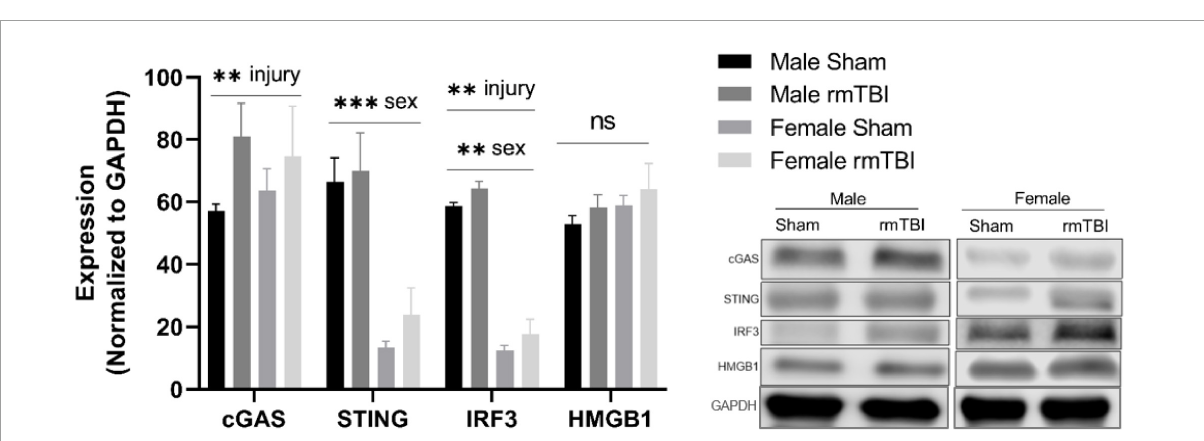
FIGURE5 cGAS-STING mediated signaling 1 week post-rmTBI. Western blotting was used to quantify proteins involved in cGAS-STING signaling 1 week after rmTBI. cGAS was significantly increased in rmTBI mice compared to shams ( p = 0.005, main effect of injury) with no sex differences. STING was significantly affected by sex ( p < 0.0001, main effect of sex), and although trending toward increased expression did not reach statistical significance for effect of injury. Post-hoc analysis revealed STING was significantly increased in sham males compared to both sham and rmTBI females (both p < 0.0001, Tukey HSD), and rmTBI males compared to both sham and rmTBI females (both p < 0.0001, Tukey HSD). IRF3 was significantly increased by injury ( p = 0.002, main effect of injury) and affected by sex ( p < 0.0001, main effect of sex). Similar to STING, post-hoc analysis indicates that IRF3 expression was significantly higher in sham males compared to both sham females and rmTBI females ( p < 0.0001, Tukey HSD). No statistical significant change for HMGB1 was observed. All statistical values are results of two-way ANOVAs with n = 4 per sex-segregated group. Error bars represent standard deviation and indication of statistical analysis is as follows: # p < 0.1, ∗ p < 0.05, ∗∗ p < 0.01, ∗∗∗ p < 0.001. ns, not